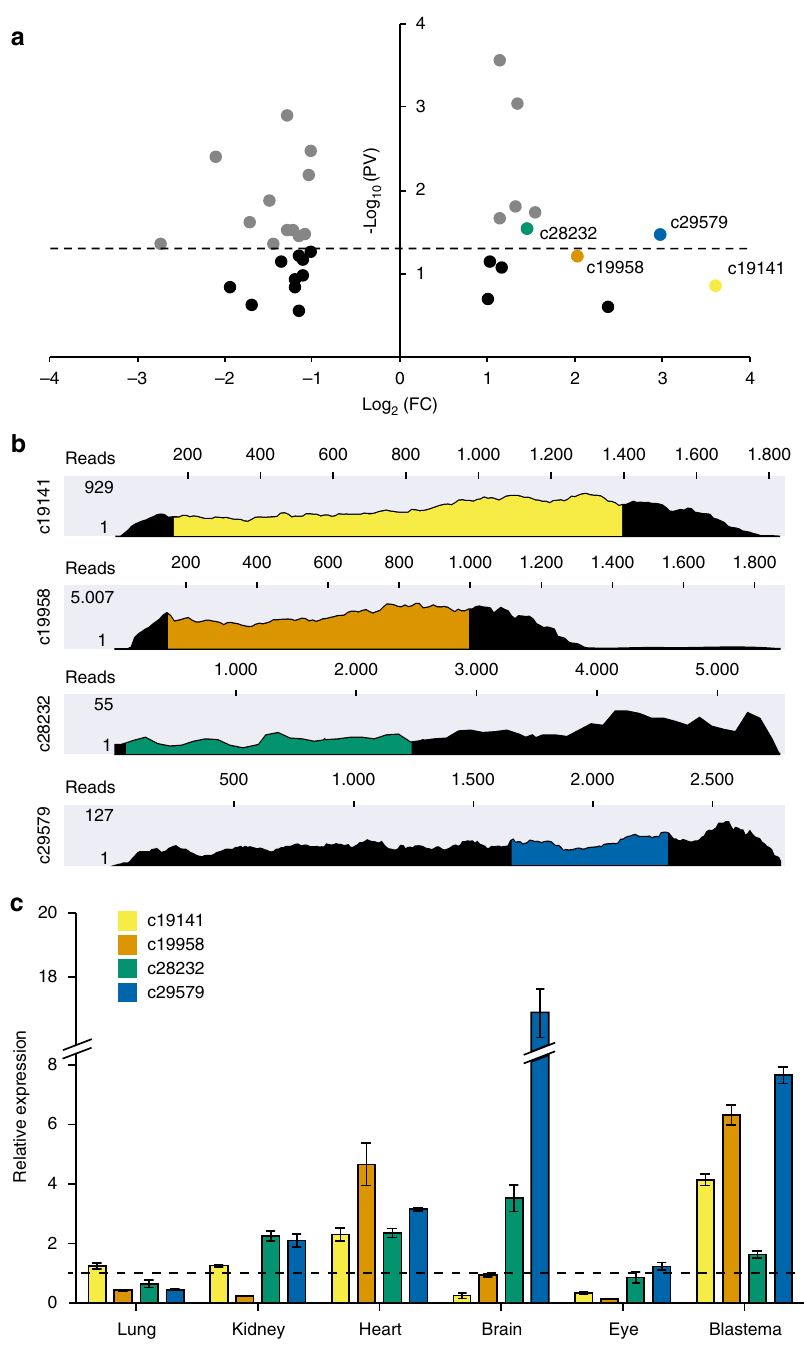
Figure 4 | Lungfish LSG expression in the FB and other adult tissues. ( a ) Volcano plot showing differentially expressed LSGs between NRF tissue and FB at 3 wpa. Each dot represents a gene and coloured dots denote four LSGs selected for further analysis (c19141, yellow; c19958, orange; c28232, green; c29579, blue). Black and grey dots represent genes below or within the P value cut-off, respectively, which is denoted by a dashed line Student’s t -test P value ( o 0.05). Fold change is displayed in a log 2 scale and P value in (cid:2) log 10 . ( b ) RNA-seq read coverage of the four candidate LSG transcripts shown in black, the predicted open reading frames (ORF) is shown in colour for each LSG, according to colour scheme in a . ( c ) Relative expression for the four, colour coded, candidate LSGs in various tissues is shown, normalized to expression level in NRF to a relative value of 1.0 (dashed line) ( n ¼ 1 biological sample, three technical replicates); mean ± s.d.; PV, P value; FC, fold